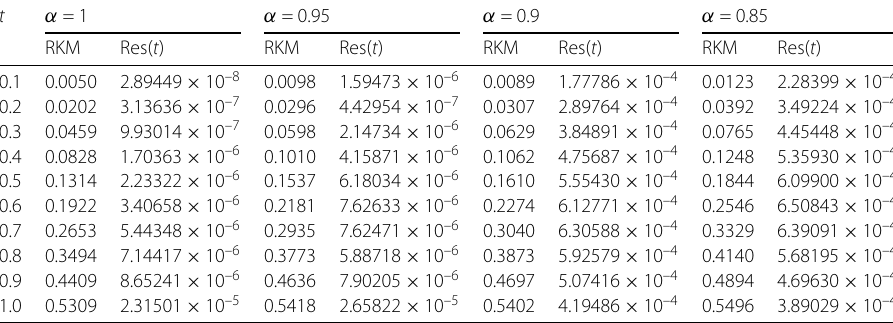
Table 3 Numerical results of Example 5.2 when n = 30 and α ∈ { 0.85,0.9,0.95,1